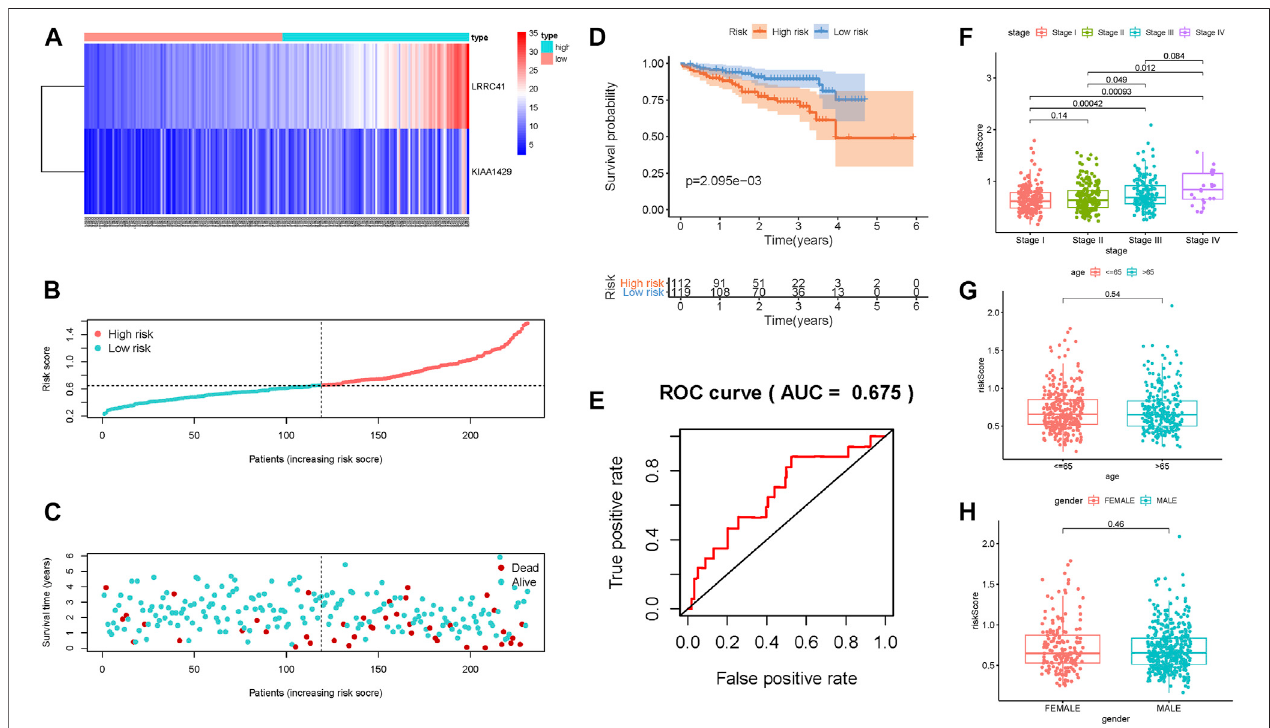
FIGURE 4 | Validation of the risk prognostic signature in the external validation group. (A) Heatmap of the candidate gene expression level in HCC. The color from red to blue shows a trend from high expression to low expression. (B) Distribution of the DNA methylation – based signature risk score. (C) Survival status and interval of HCC patients. (D) Kaplan – Meier curve analysis presenting difference of overall survival between the high-risk and low-risk groups. (E) ROC curve analysis of the risk scoresfor overallsurvival predictive signi fi cance.Comparison ofriskscores indifferentsubgroupsbased on age (F) ,gender (G) , and clinicopathological stage (H) .